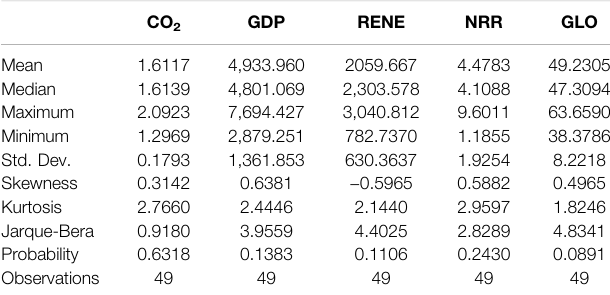
TABLE 2 | Descriptive